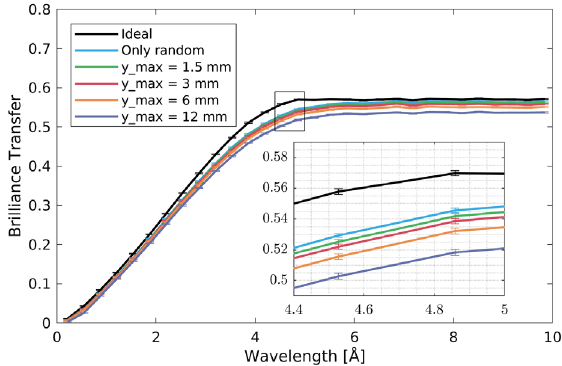
FIG. 7. Brilliance transfer as a function of wavelength for a straight guide under displacement model 3, with 4 m guide sections and 0.5 m guide